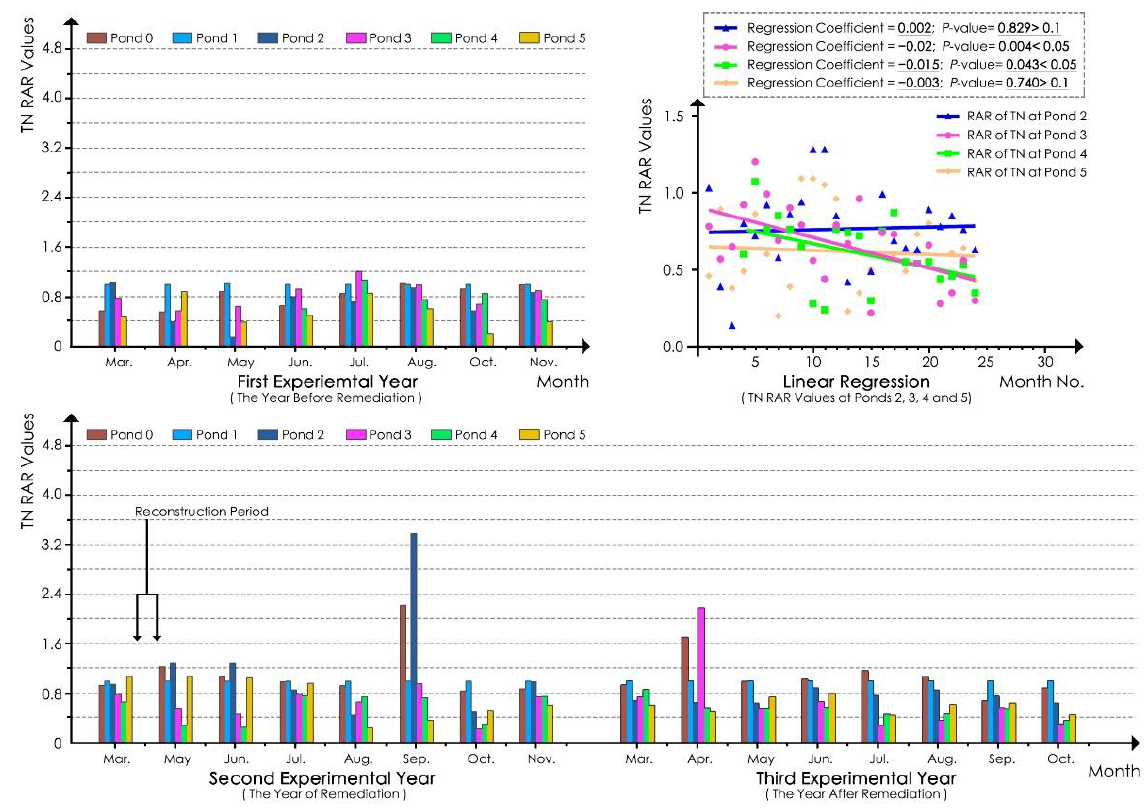
Figure 5. TN RAR values for each pond.